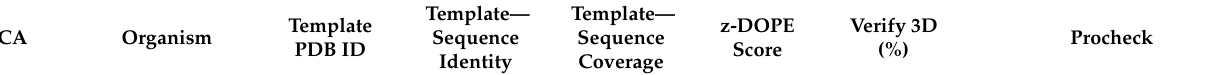
servation. Residues in the red boxes are important for catalysis while Zn 2+ coordinating His resi- the red boxes are important for catalysis while Zn 2+ coordinating His residues are shown in green dues are shown in green boxes. The black box depicts the insert present for Cam, CcmM, and EcoCA- γ. The blue dots show proton shuttling Glu residues identified in Cam. Yellow box depicts boxes. The black box depicts the insert present for Cam, CcmM, and EcoCA- γ . The blue dots show residues around the hydrophobic region in the catalytic site of γ -PmCA. proton shuttling Glu residues identified in Cam. Yellow box depicts residues around the hydrophobic region in the catalytic site of γ -PmCA. Table 1. Template coverage, sequence identity and model validation for γ -CA sequences. Table 1. Template coverage, sequence identity and model validation for γ -CA